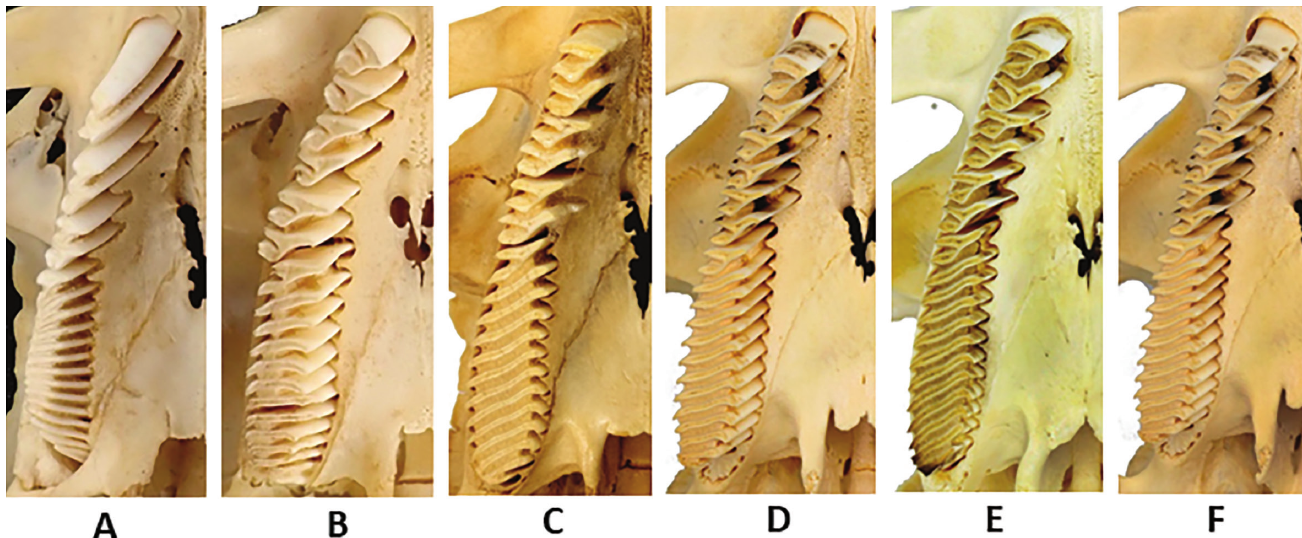
Figure 9. Ontogenetic series of right mandibular tooth rows in Hydrochoerus hydrochaeris . A, Age Class I with no wear on anter- ior teeth (MSCC 456); B, Age Class I with wear on all teeth (MSCC 457); C, Age Class II (MSCC 463); D, Age Class III (MSCC 461); E, Age Class IV – V (MSCC 4620; F, Age Class VII (MSCC 460). Measurements of the upper third molar (M3) are provided in Table